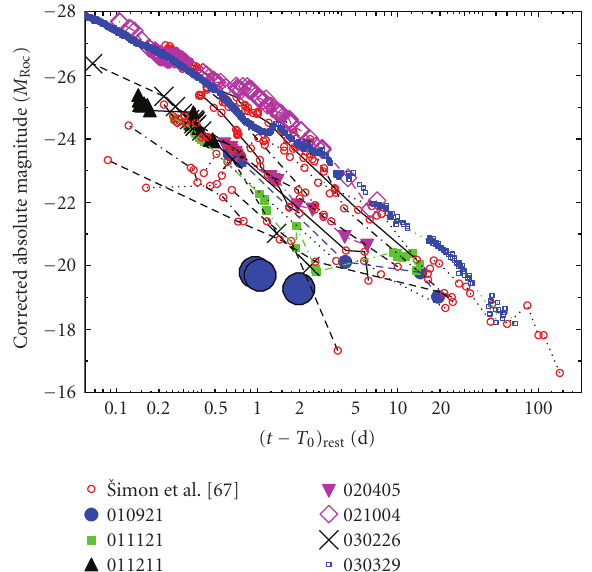
Figure 9: k -corrected absolute R magnitudes of the ensemble of optical afterglows of long GRBs from [67, 68]. The magnitudes of the early phase of optical afterglow of GRB 060218 are plotted as large closed circles. Rest frame time interval ( t − T 0 ) the abscissa.